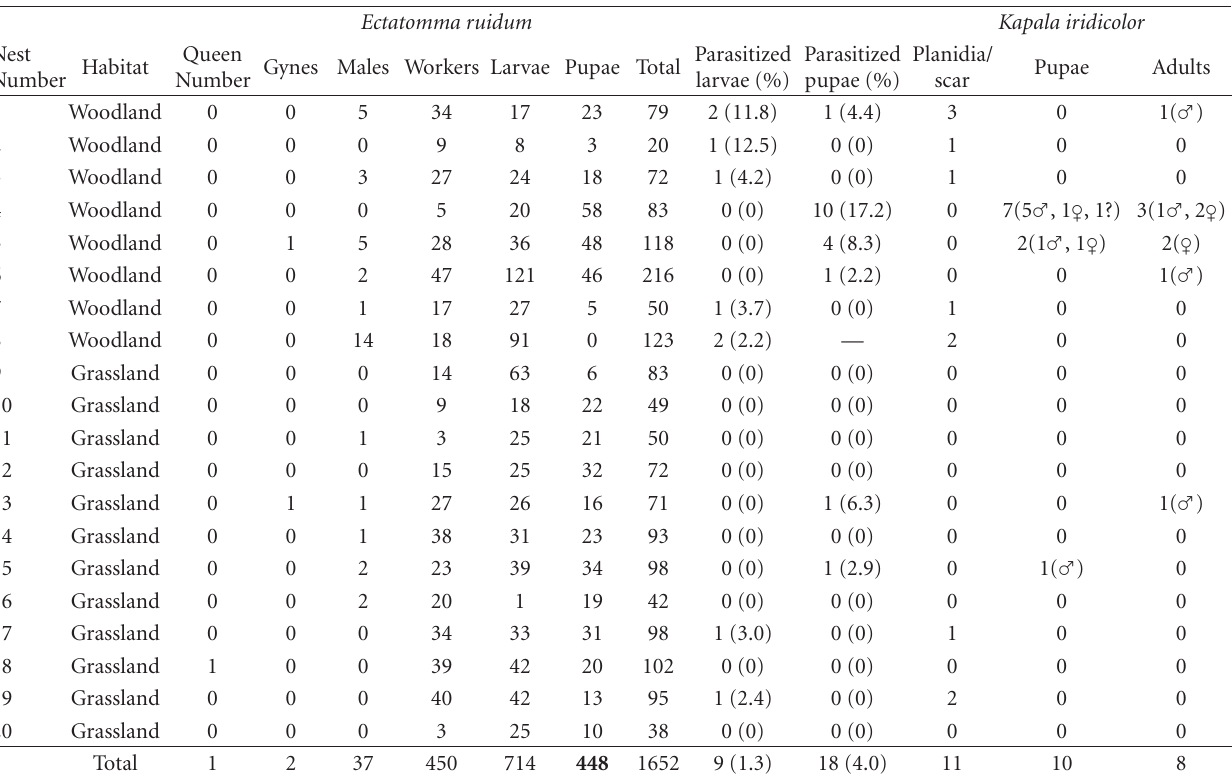
a sclerotized ring (Figures 2(b) and 2(c)) while one was not (Figure 2(e)). In 5 cases, sclerotized rings with no planidia were observed (Figure 2(d)). In 2 host larvae from di ff erent colonies, 2 planidia (or empty scars) were observed (representing 22% of the parasitized larvae, 2/9). Very small host larvae were found parasitized. The length of parasitized larvae ranged from 2.77 to 10.10 mm ( n = 8).